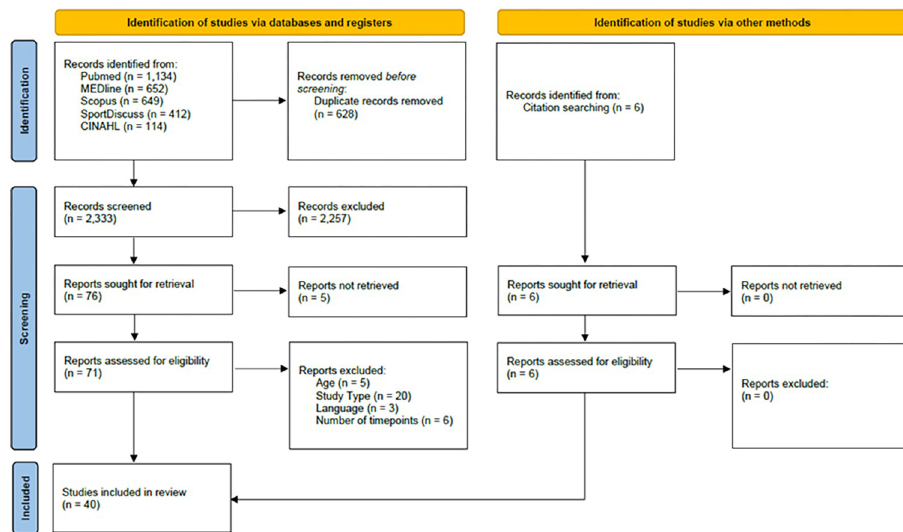
Fig 1. Flow of selection process of eligible studies for qualitative